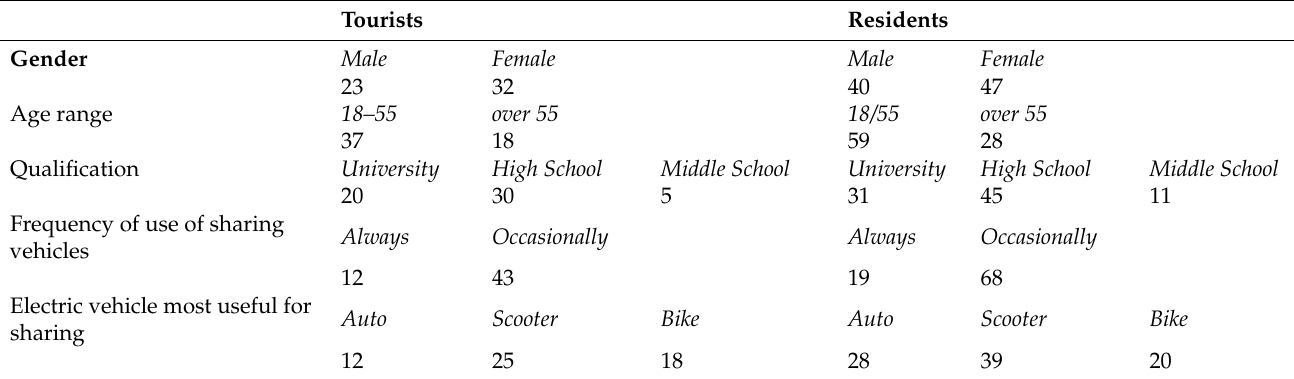
Table 2. Profile of the interviewees.